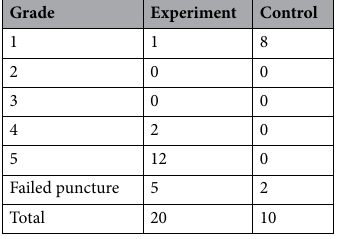
Table 1. Neurologic Outcome.